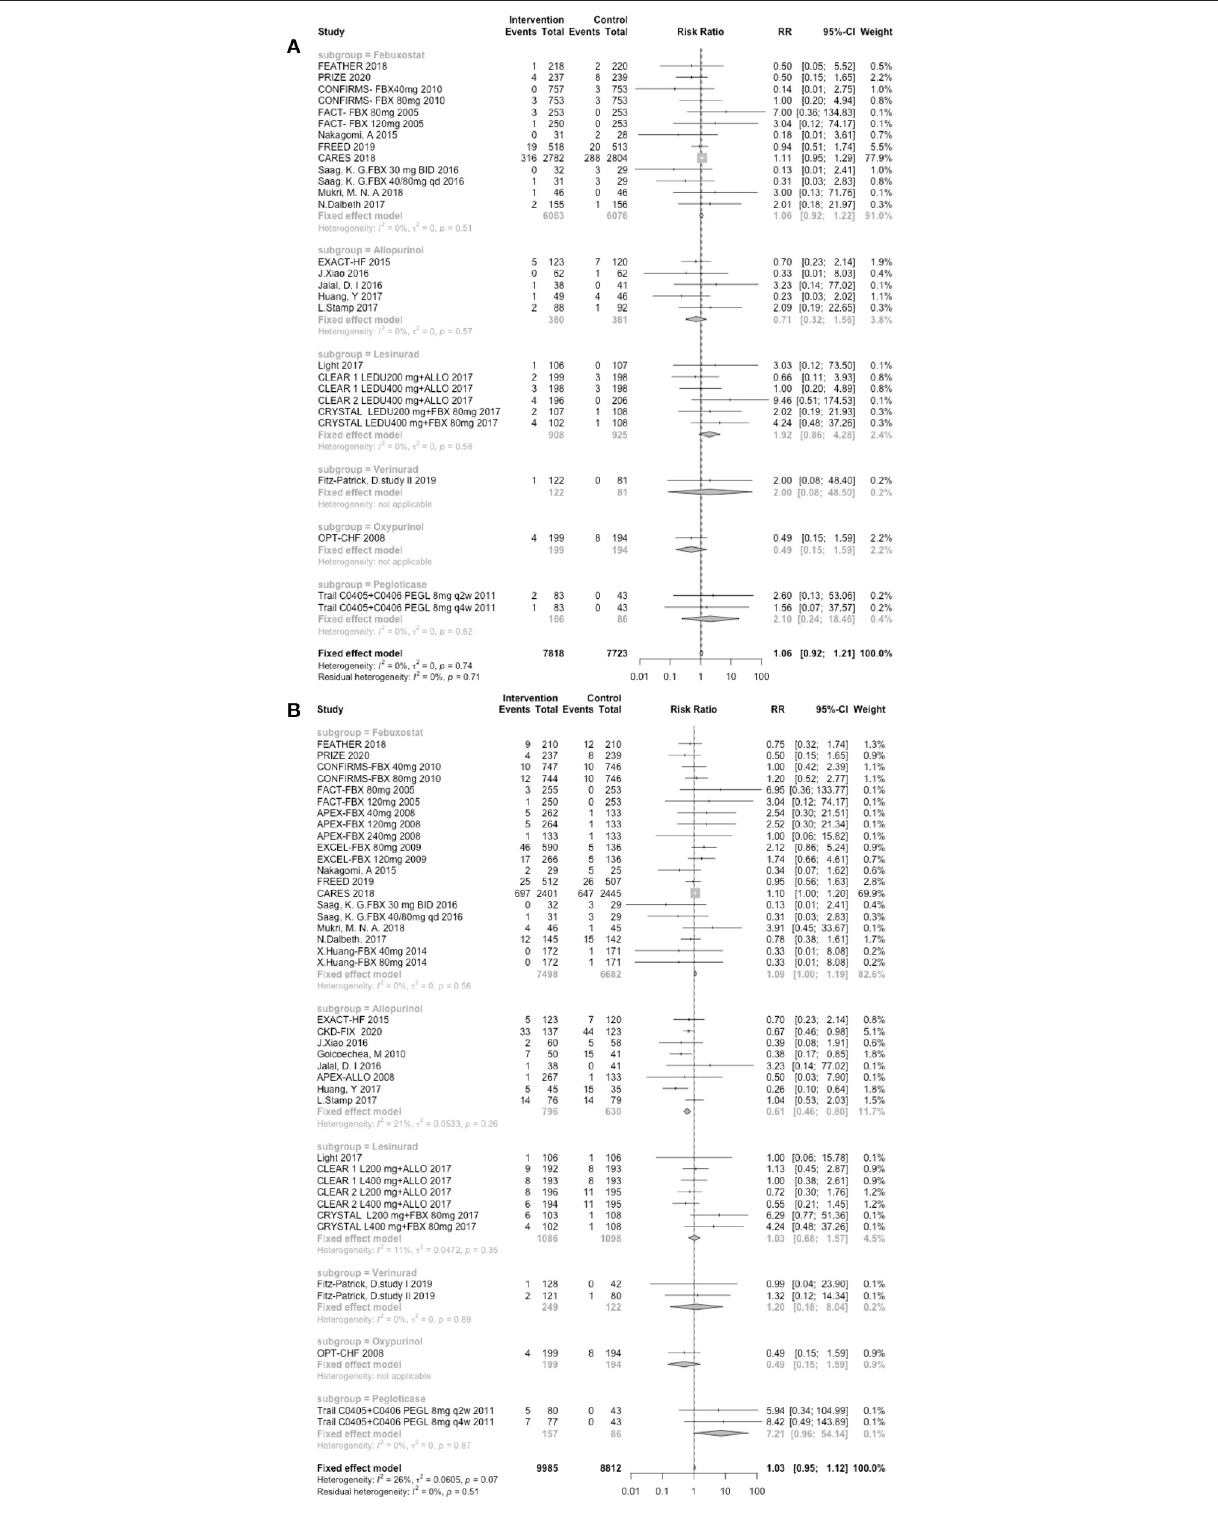
Frontiers in Cardiovascular Medicine |